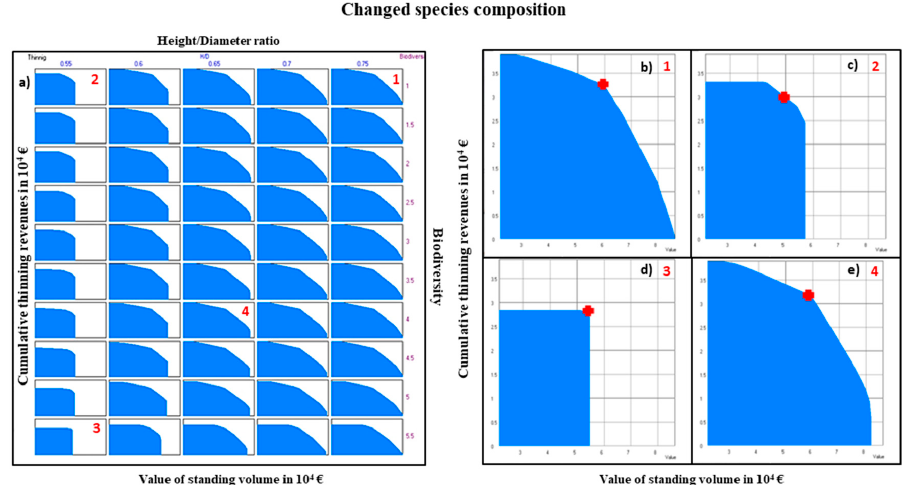
Figure 4. ( a ) Interactive decision maps (IDM) are representing a trade-o ff between the value of the standing volume and cumulative revenues from thinning at a specific level of H / D and B index for a representative forest stand (RST) with a changed species composition. Blue areas represent the set of the feasible solutions that contain Pareto optimal solutions on the hull frontier. ( b ) IDM that will be probably chosen by the economically oriented risk-seeking owner, ( c ) IDM probably selected by economically oriented risk-avoiding owner, ( d ) IDM suitable for nature-oriented decision-maker (DM) and ( e ) IDM that is likely to be chosen by the balanced